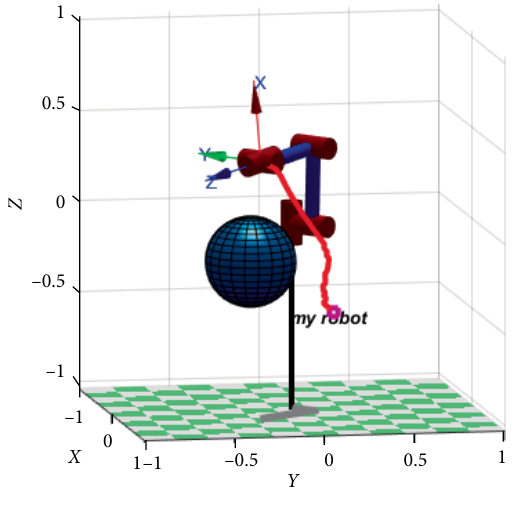
Figure 2: Path plan of an obstacle.